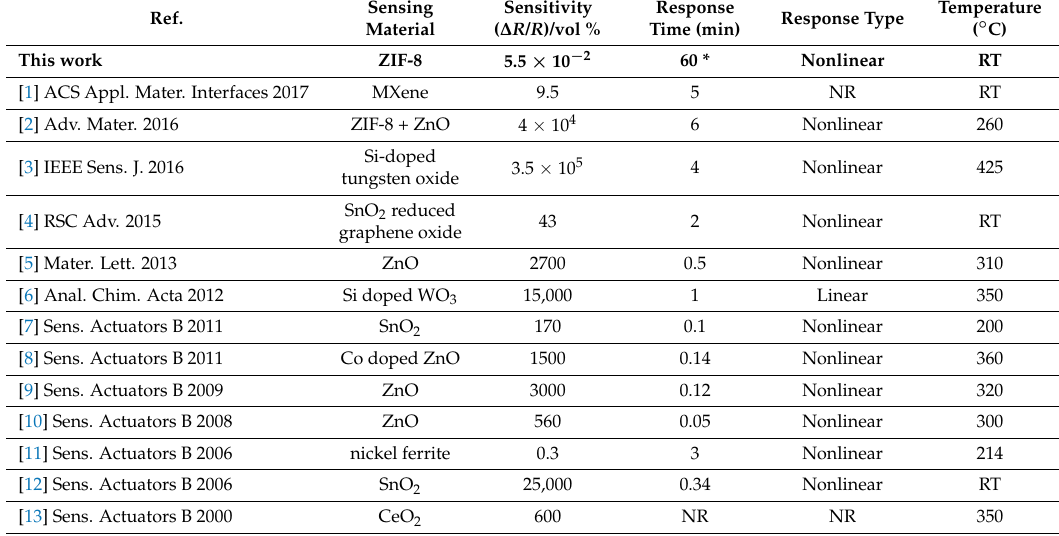
Table 5. Comparison of the previously reported resistive transduction-based acetone sensors.